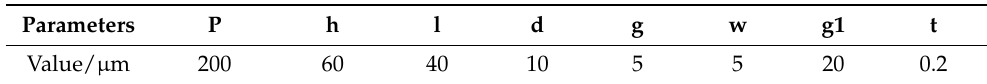
Figure 1. Schematic diagram of the sensor structure. ( a ) Top view and ( b ) geometric parameters of the amplification unit cell. Table 1. Dimensional parameters of the sensor.